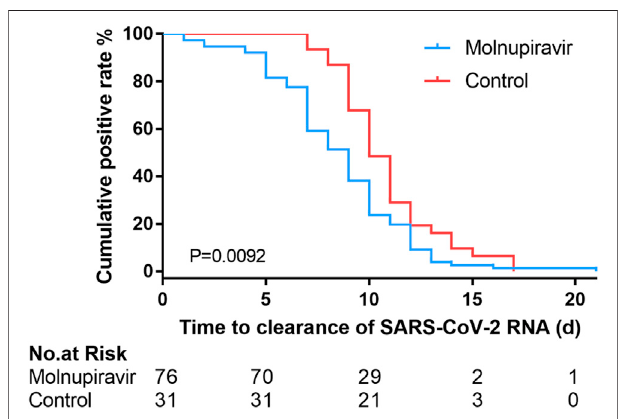
FIGURE2| Kaplan-MeierplotshowingthetimeofviralRNAclearancein the molnupiravir and control groups.